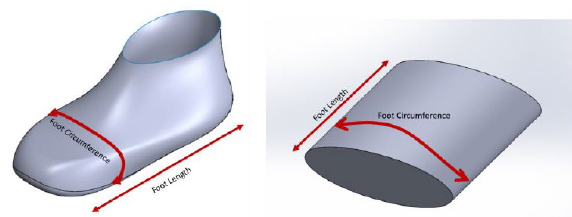
Figure 26. Assumption of the foot as an ellipse shape.